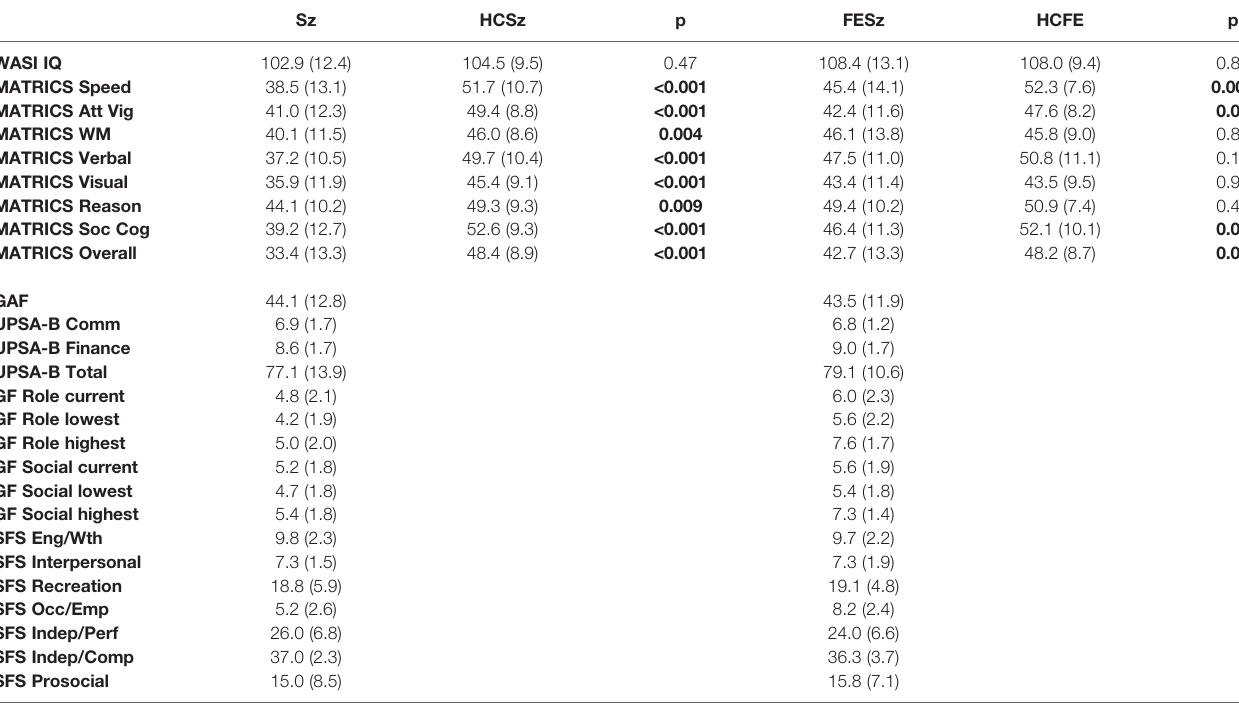
TABLE 2 | Neuropsychological and social functioning information. Sz HCSz p FESz HCFE p WASI